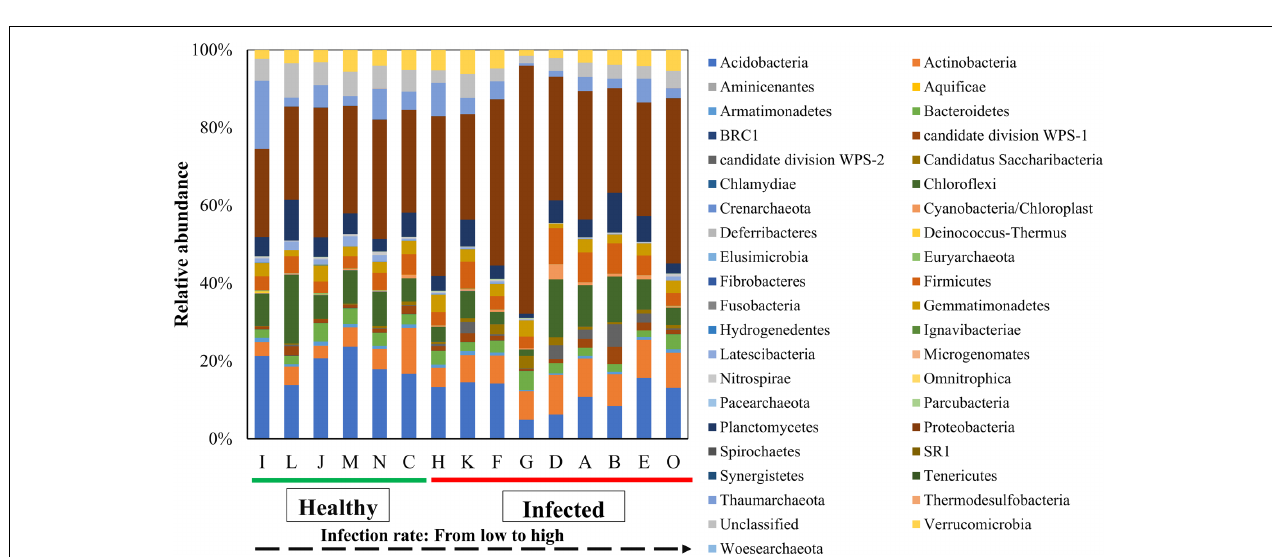
FIGURE 3 | Average relative abundance of bacterial phylum in soil samples. Results are means of 10 replicates. All sites can be grouped into two groups: ‘Healthy’ that has the infection rate of less than 25% and ‘Infected’ that has the infection rate more than 25%.